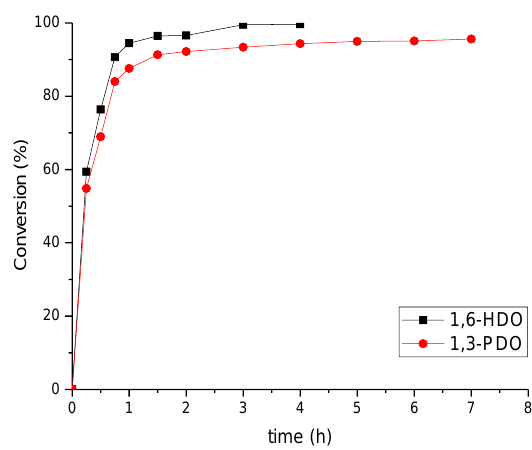
Figure 1. Conversion of the polycondensation reaction of IA with HDO ( squares ) and PDO ( circles ).